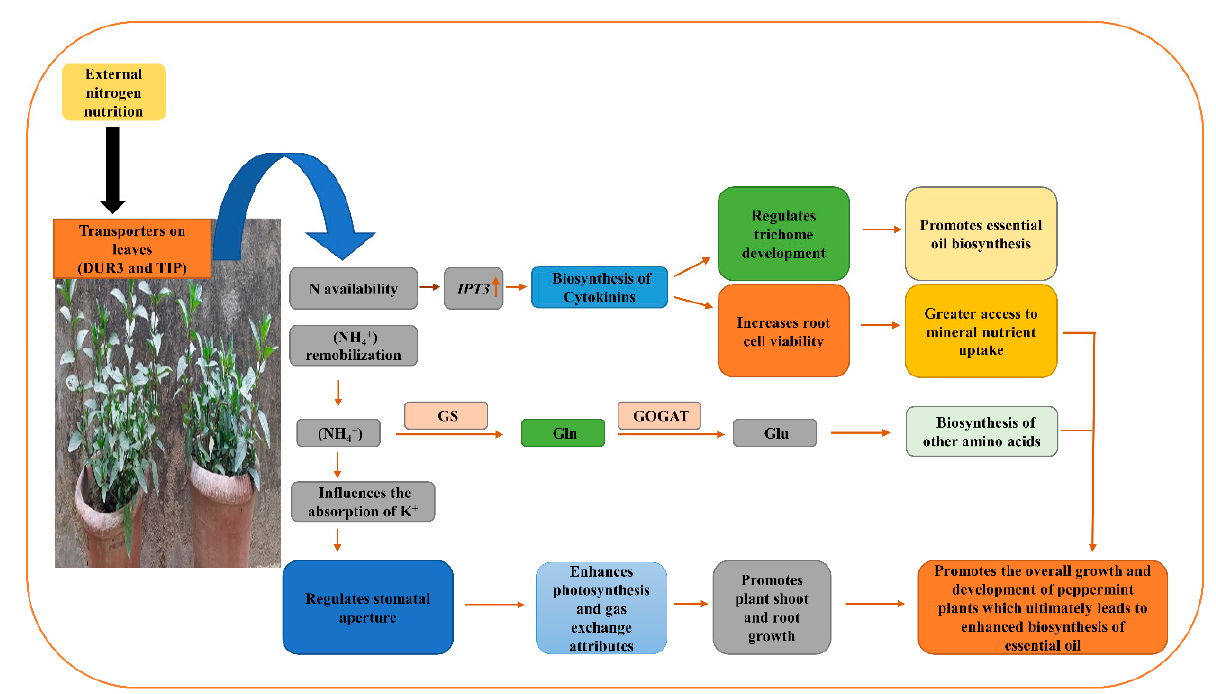
Figure 16. A schematic representation showing the potential mechanism of N application in improving the performance of peppermint plants. IPT3 : adenylate isopentenyl transferase; GS: Glutamine synthetase; GOGAT: Glutamine oxoglutarate aminotransferase; Gln: Glutamine; Glu: Glutamate. Upward arrow indicates upregulation.